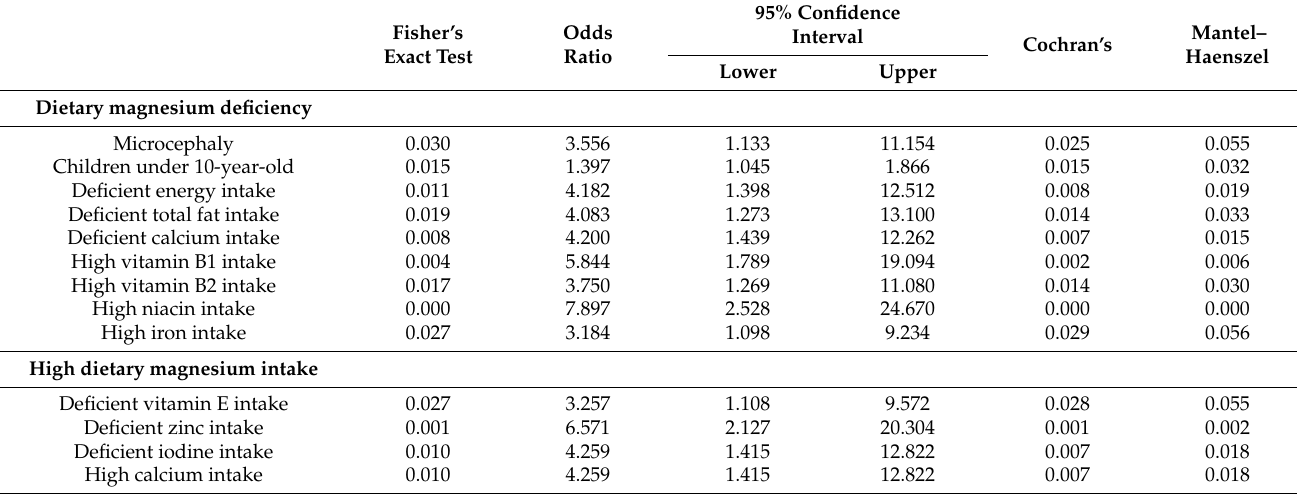
Table 6. Significant Odds Ratios throughout the series ( n = 78).